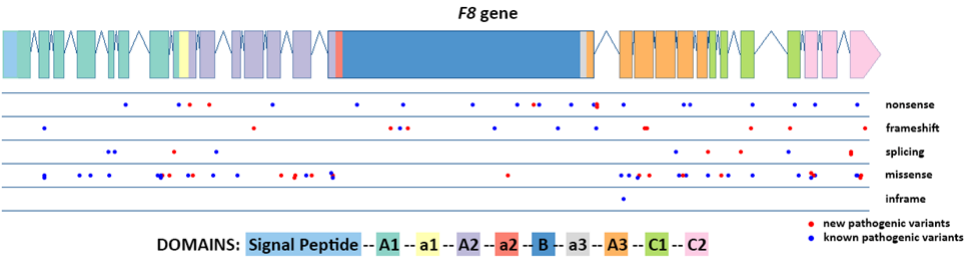
Figure 4. Distribution of different pathogenic variant types found among 267 patients from Russia, except for inversions and large